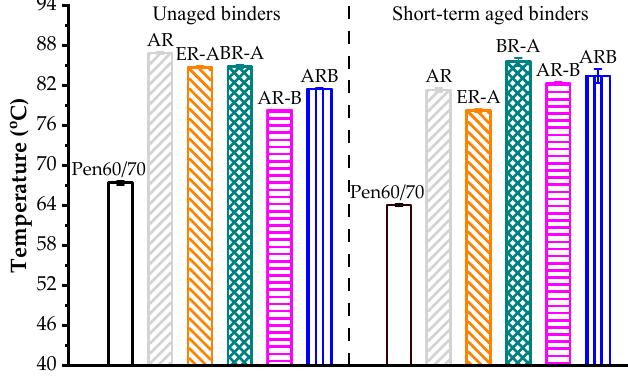
Figure 3. Superpave rutting factor results.